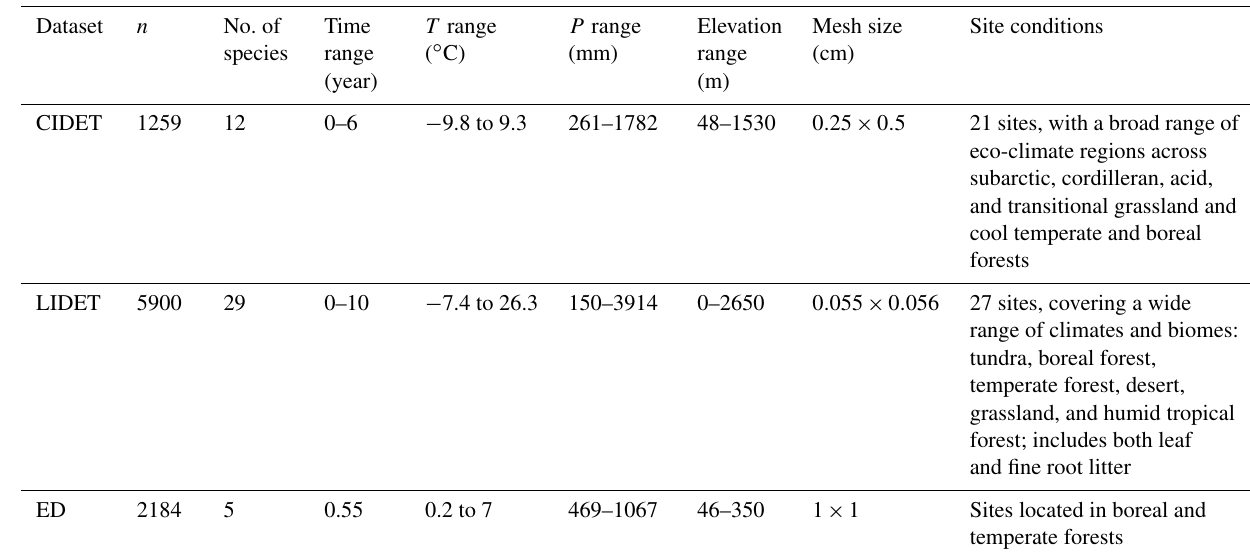
Table B1. Dataset description with general environmental condi-